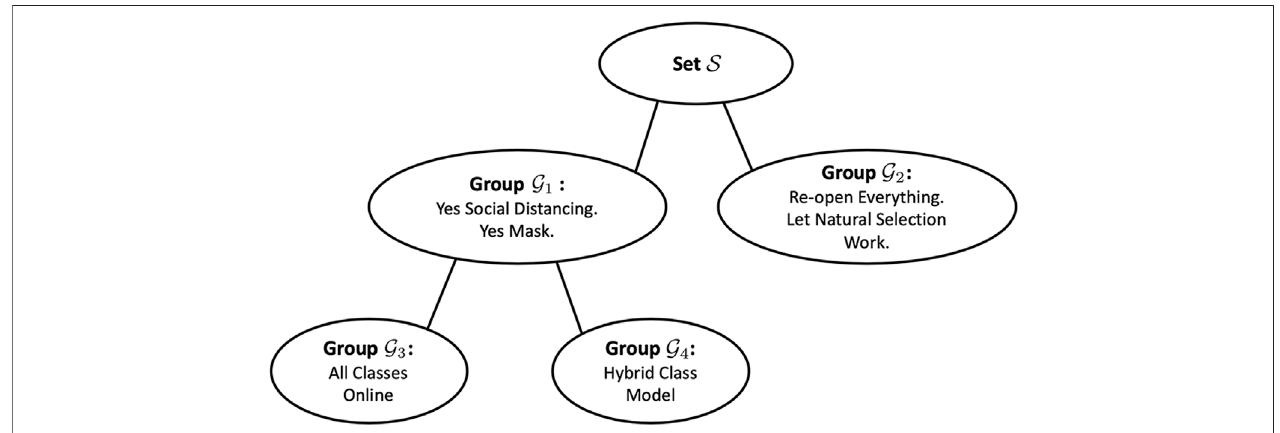
FIGURE 1 | A notional example of hierarchical overlapping